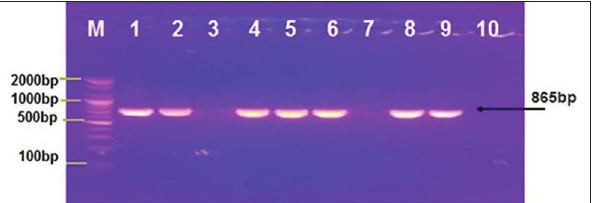
Figure-2: Agarose gel electrophoresis; positive bands of serotype A virus of foot-and-mouth disease in samples 1, 2, 4, 5, 6, 8, and 9.